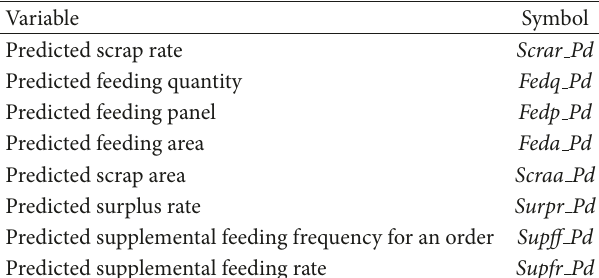
Figure 6: ANN-based architecture for the prediction of scrap rate and material feeding optimization (one can refer to Tables 1 and 2 for the notations). Table 2: Prediction results related